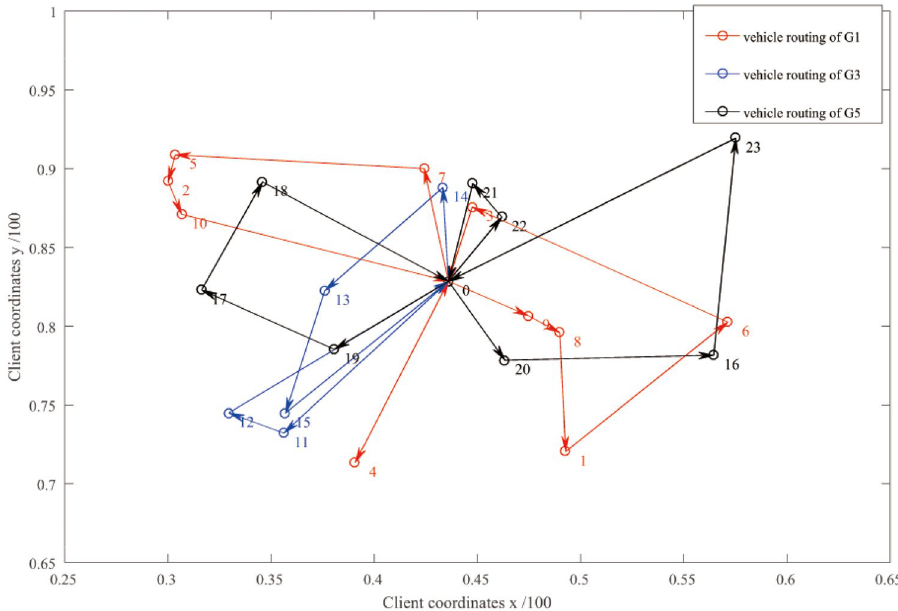
Figure 4. Distribution route optimization of vehicle for HSR G1, G3,